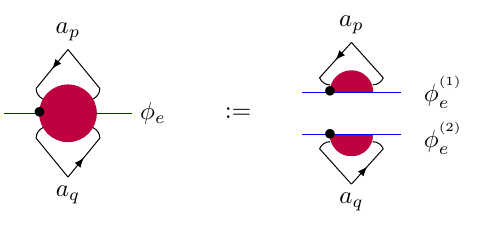
Figure 14 . Gluing the faces with the coproduct of H ∗ , ∆ φ e = φ (1) e ⊗ φ (2) e .